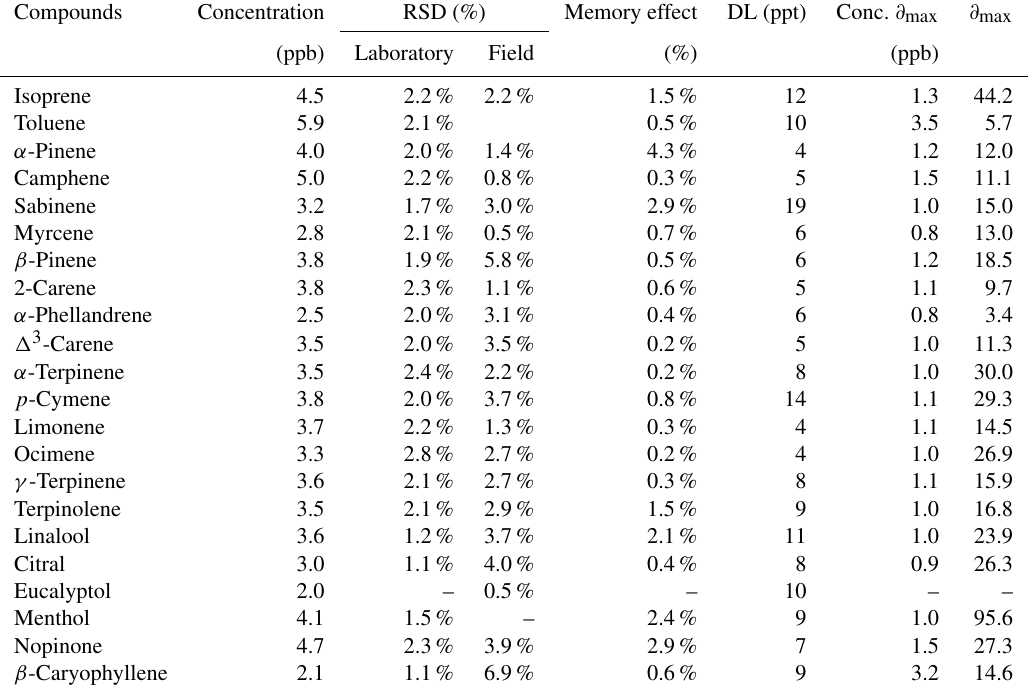
Figure 6. The canisters’ response coefficient relative deviation from the NPL response coefficient. The legend displays the following infor- mation: the canister creation date (ddmmyyyy), the canister used (B denotes S053 and O denotes S052), and the number of replicates ( n ). Error bars show 1 standard deviation (1 σ ). Table 5. Concentrations, relative standard deviations (RSD), memory effect, detection limits (DL), and concentrations of the maximal relative residual, ∂ max (in %), measurement at 80% RH (22 ◦ C) for the target compounds. Compounds Concentration RSD